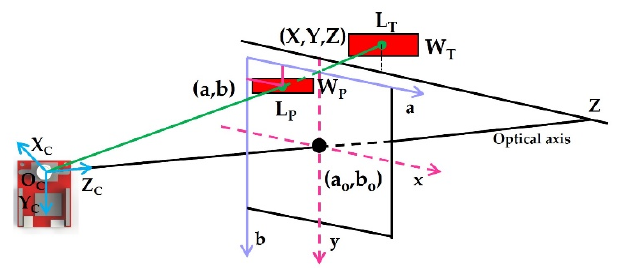
Figure 4. Transform the coordinate system.